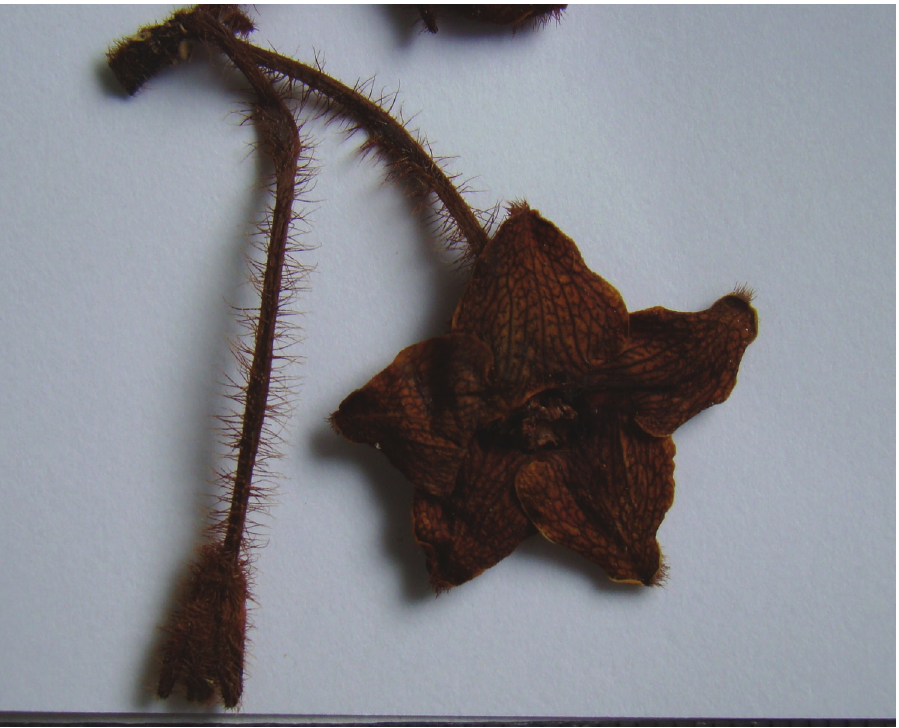
Figure 6. Detail of flower (adaxial view) of Phaeostemma surinamensis from holotype ( Lindeman et al. 654 ,